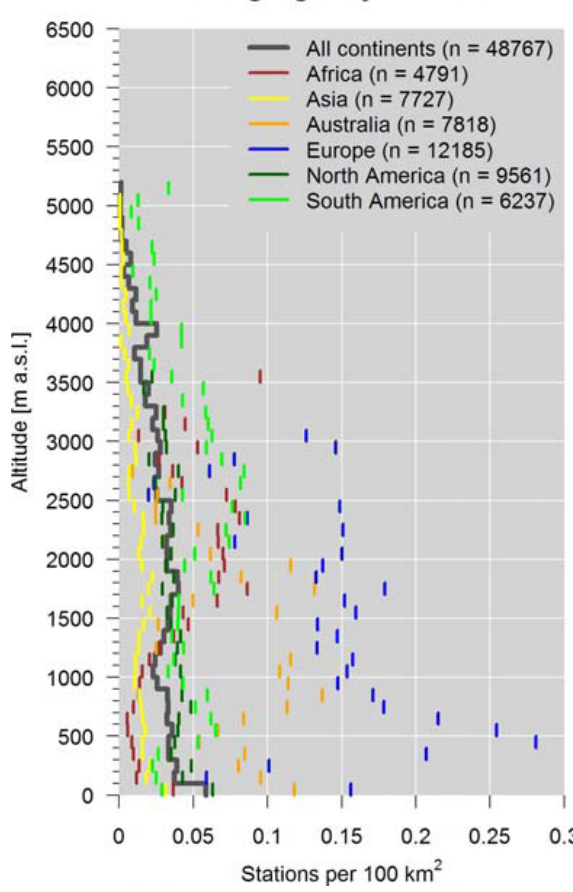
Fig. 4. Density of precipitation stations represented in the GPCC archive per continent and altitudinal